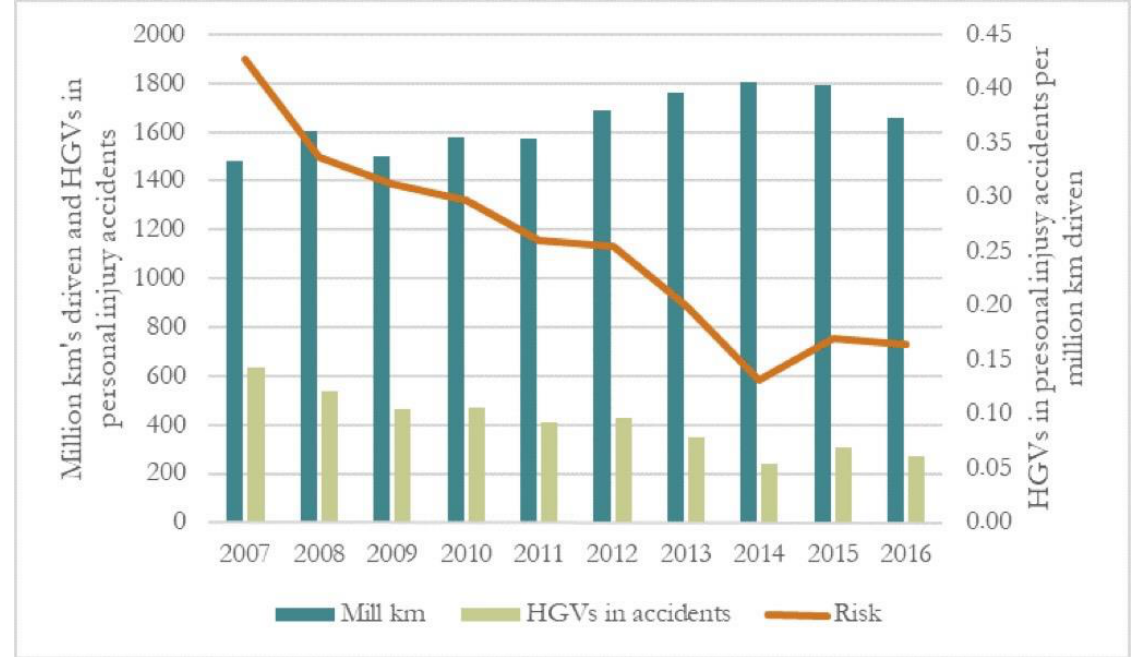
Figure 2. Million kms driven and the number of Norwegian-registered HGVs driven by employed drivers in trucking companies (rental transport or reward) and other companies (transport for own account), involved in personal injury accidents per year 2007 – 2016 (left-hand scale), and risk per year (right-hand scale). Figure 2 indicates that the risk of personal injury accidents for HGVs was reduced by 63% in the period 2007 – 2016.